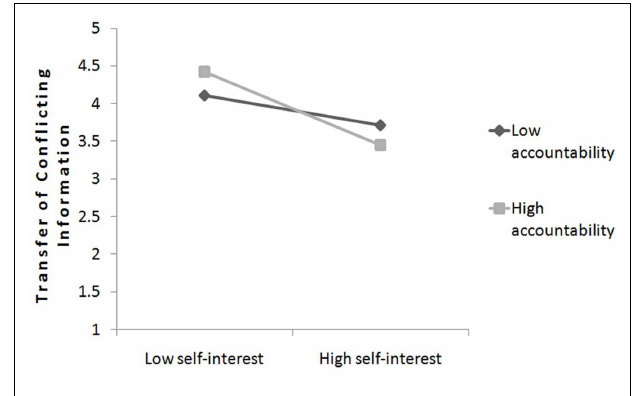
FIGURE 4 |The relationship between self-interest and transferring conflicting information as a function of advisor’s perceived accountability (study 2).